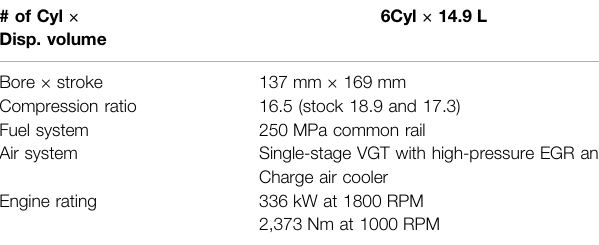
TABLE 1 | Base engine speci fi cations. # of Cyl × Disp. volume